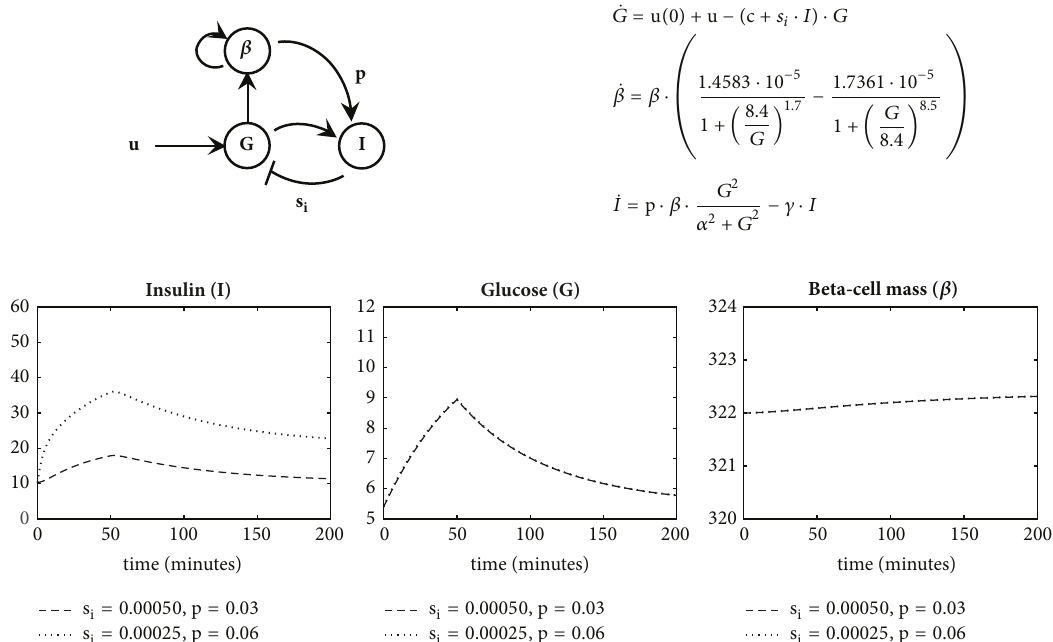
Figure 1: Illustration of observability and structural identifiability issues. Top: diagram and equations of the ‘ 𝛽 IG model’ of the glucose- insulin system [35]. If glucose concentration (G) and 𝛽 -cell mass are measured, the parameters 𝑝 and 𝑠 𝑖 are structurally unidentifiable: the bottom plots show that different combinations of 𝑝 and 𝑠 𝑖 values yield identical curves of G and 𝛽 , so it is not possible to distinguish between them as long as the product 𝑝 ⋅ 𝑠 𝑖 , which is structurally identifiable, remains constant. Likewise, in this case insulin concentration (I) is an unobservable state: it is not possible to determine which of the two time courses of I shown in the lower left plot is the true